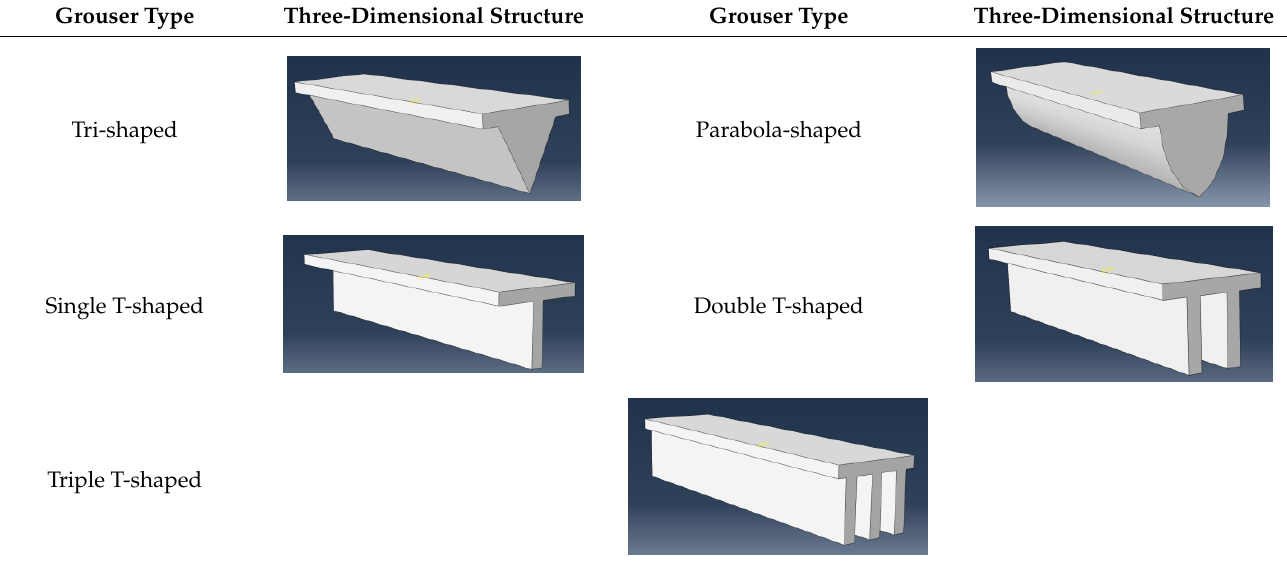
Table 10. Different grouser types and numbers setting.